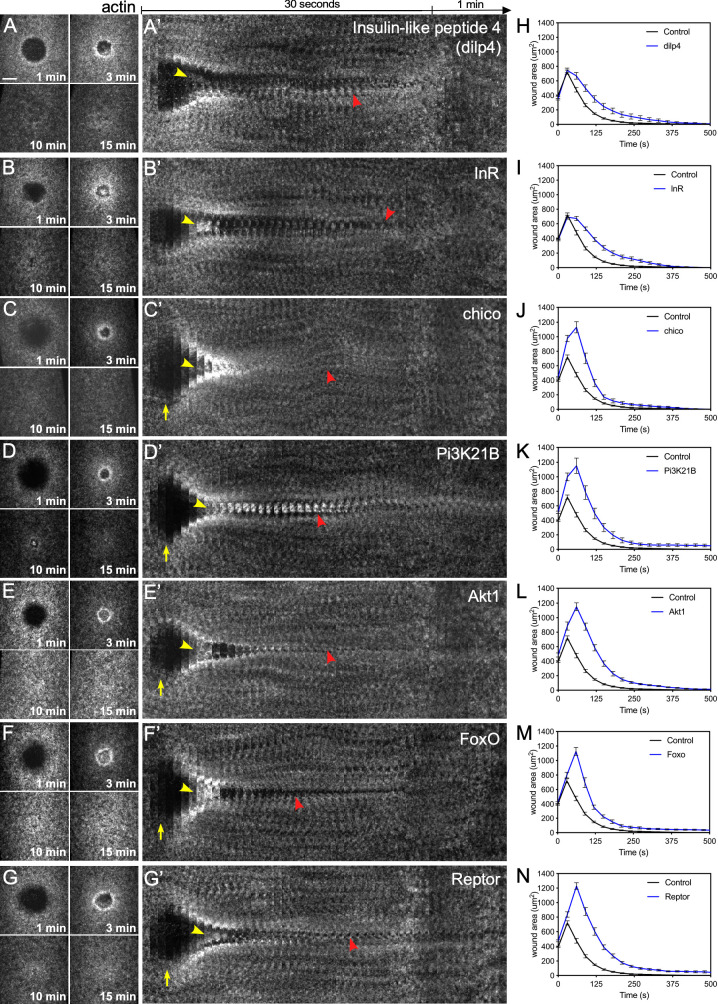
Actin dynamics of insulin/insulin-like (IIS) pathway mutants.(A-G) Confocal XY projections of actin dynamics at 1, 3, 10, and 15 mpw during cell wound repair in Drosophila NC4-6 embryos expressing sGMCA and a mutant for insulin-like peptide 4 (Ilp41; A), or a UAS-RNAi transgene for InRRNAi(1)/+; InRRNAi(2)/sGMCA, 7063 (B), ChicoRNAi/sGMCA, 7063 (C), Pi3K21BRNAi/sGMCA, 7063 (D), Akt1RNAi/sGMCA, 7063 (E), FoxORNAi/sGMCA, 7063 (F), and ReptorRNAi/sGMCA, 7063 (G). (A’-G’) XY kymographs across the wound areas depicted in (A-G), respectively. Note wound overexpansion (yellow arrows), wound underexpansion (green arrows), internal actin accumulation (yellow arrowhead), and remodeling defect/open wound (red arrowhead). (H-N) Quantification of wound area over time for (A-G’), respectively. Error bars represent ± SEM; n ≥ 10. See S3 Table for numerical data. Scale bars: 20 μm.